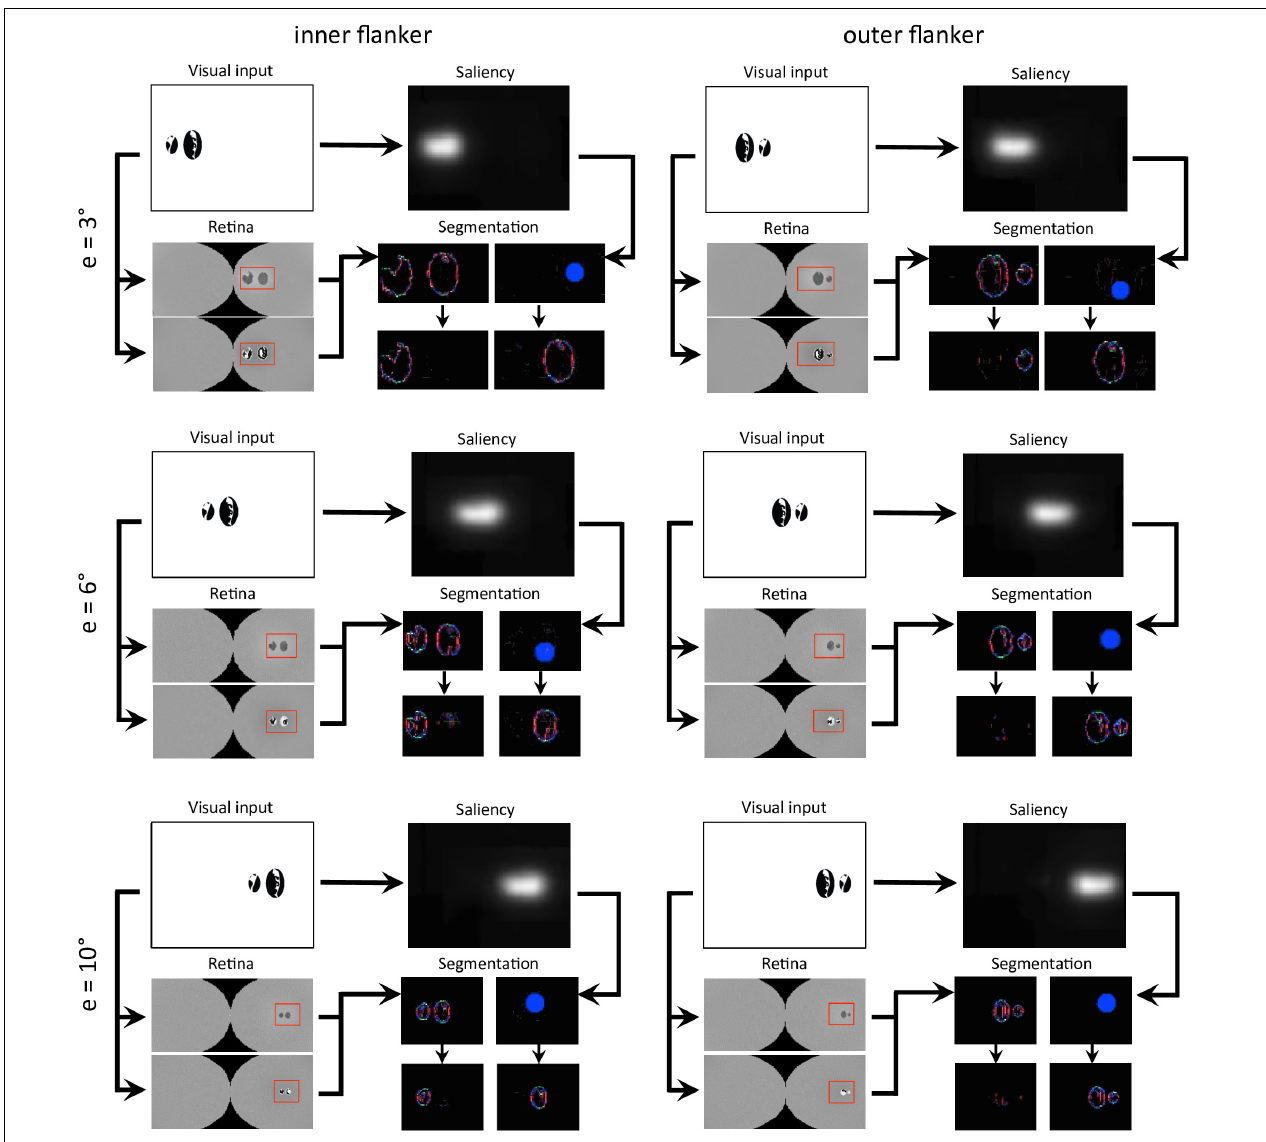
FIGURE 12 | Output of all models and for all conditions of experiment 5 of Farzin et al. (2009; see Figures 3B–C ). The description of the windows for each condition is the same as in Figure 9 . Each row of conditions displays the output of the visual system for a specific eccentricity. Note that the visual stimulus appears smaller in the retina model’s output (and hence in the segmentation model’s output) as the eccentricity grows. To highlight how different it is to segment the flanker from the target for various eccentricities, the output of the retina model as well as the segmentation model have the same scale across the conditions (e.g., the selection signal always has the same